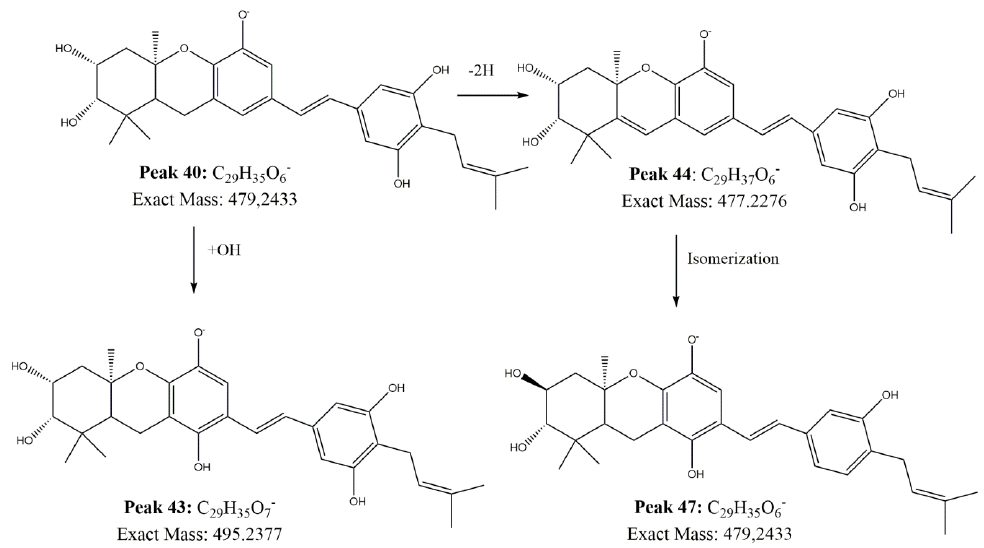
Figure 2. Proposed biosynthesis and structures of Vedelianin and some derivatives in Z punctata .